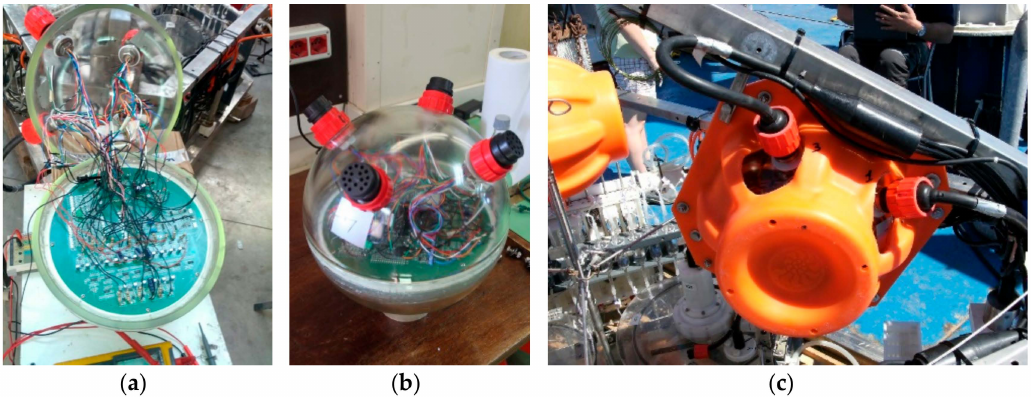
Figure 7. Amerigo Lander electronics: ( a ) Firmware testing phase and soldered cables inside the glass sphere; ( b ) electronics fitted in the glass sphere; ( c ) a glass sphere mounted on the tripod with the plastic case, marine connectors, and